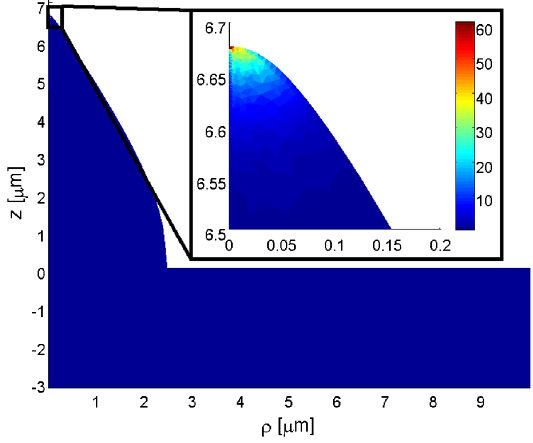
FIG. 6. j J j 2 in ½ A =(cid:1) m 2 (cid:2) 2 for a o ¼ 1 (cid:1) m , r ¼ 0 : 85 , N ¼ 21 , 300 MV = m . F o ¼